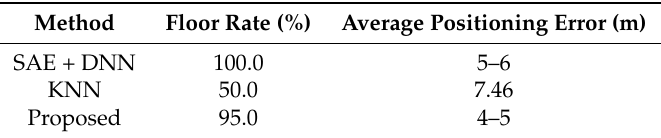
Table 5. Experimentation results for option